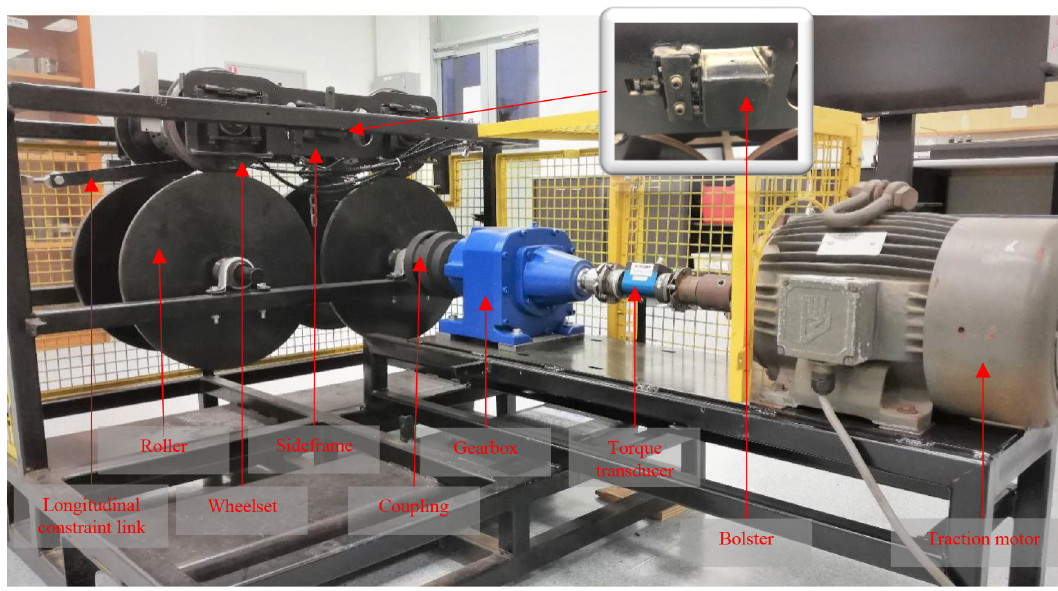
Fig. 2 Methodology to solve the research questions